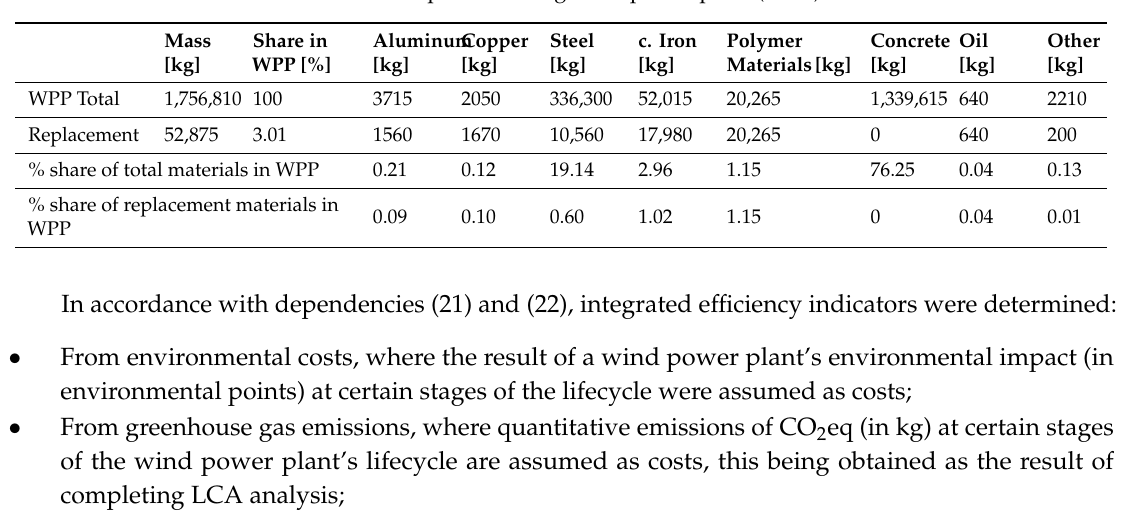
Table 3. Mass of materials replaced during wind power plant (WPP)